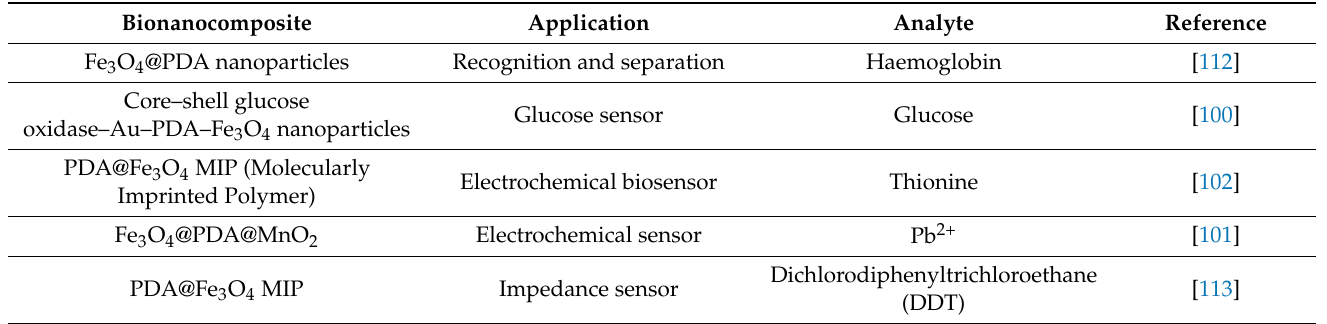
Table 3. Fe 3 O 4 @PDA nanocomposites for sensing